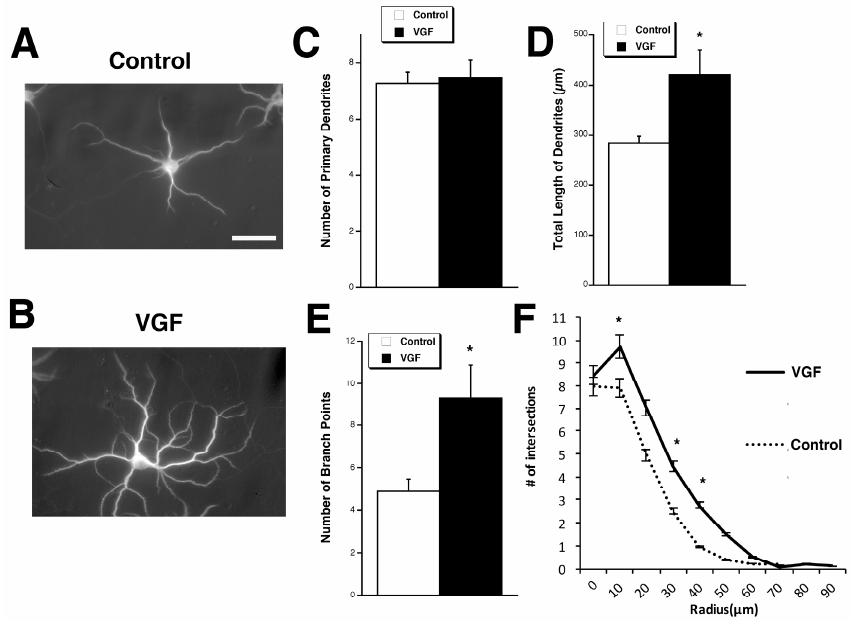
Figure 1. TLQP-62 peptide promotes dendritic branching and length but not number of primary dendrites. ( A,B ) Representative images of hippocampal neurons treated with 3 µM TLQP-62 (VGF) ( A ) or vehicle (control) ( B ) from 4–7 days in vitro (DIV). Scale bar = 60 µm; ( C – F ) Quantitation of morphological parameters shows that TLQP-62 has no effect on the number of primary dendrites ( C ) but increases the total length of dendrites ( D ) and the number of branch points as shown by total number of branch points ( E ), as well as Sholl analysis ( F ) ( n = 35). Bars represent average ± SEM. Two-sample t